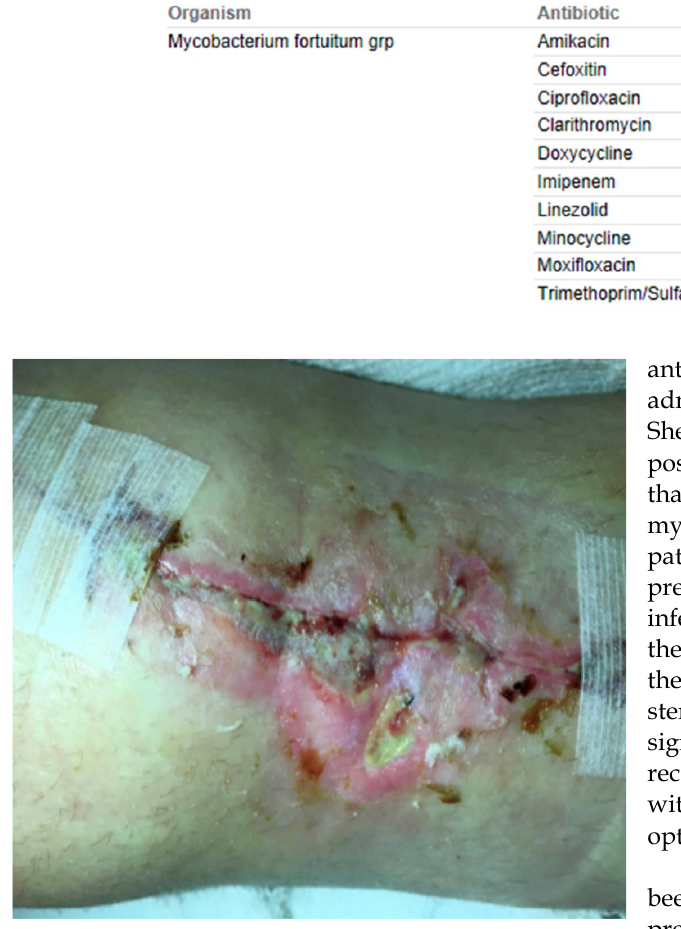
Figure 3. Wound 11 weeks